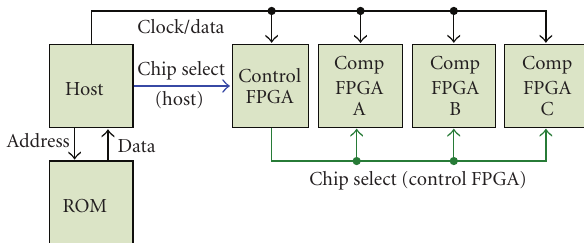
Figure 6: Passive serial configuration of the FPGAs on an FLC at system startup time: firstly, the control FPGA and after that the computing FPGAs are configured in parallel with configuration data from an embedded ROM.